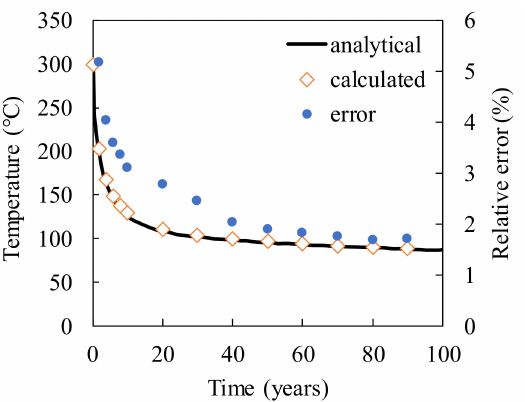
Figure 1. Comparison between the calculated and Gringarten’s analytical